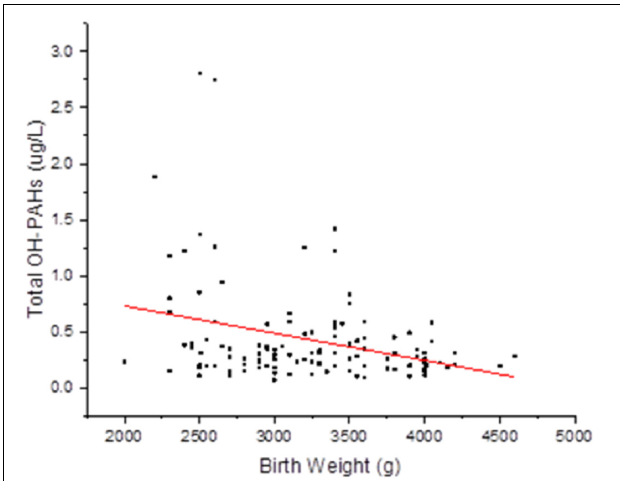
FIGURE 2 | Correlation between methylation levels of imprinting gene H19 in Sperm DNA and new born BW. Methylation levels of imprinting gene H19 in Sperm DNA were negative correlated to new born BW in this study. Each point on the graph represents individual measurement and red line represents Liner fit